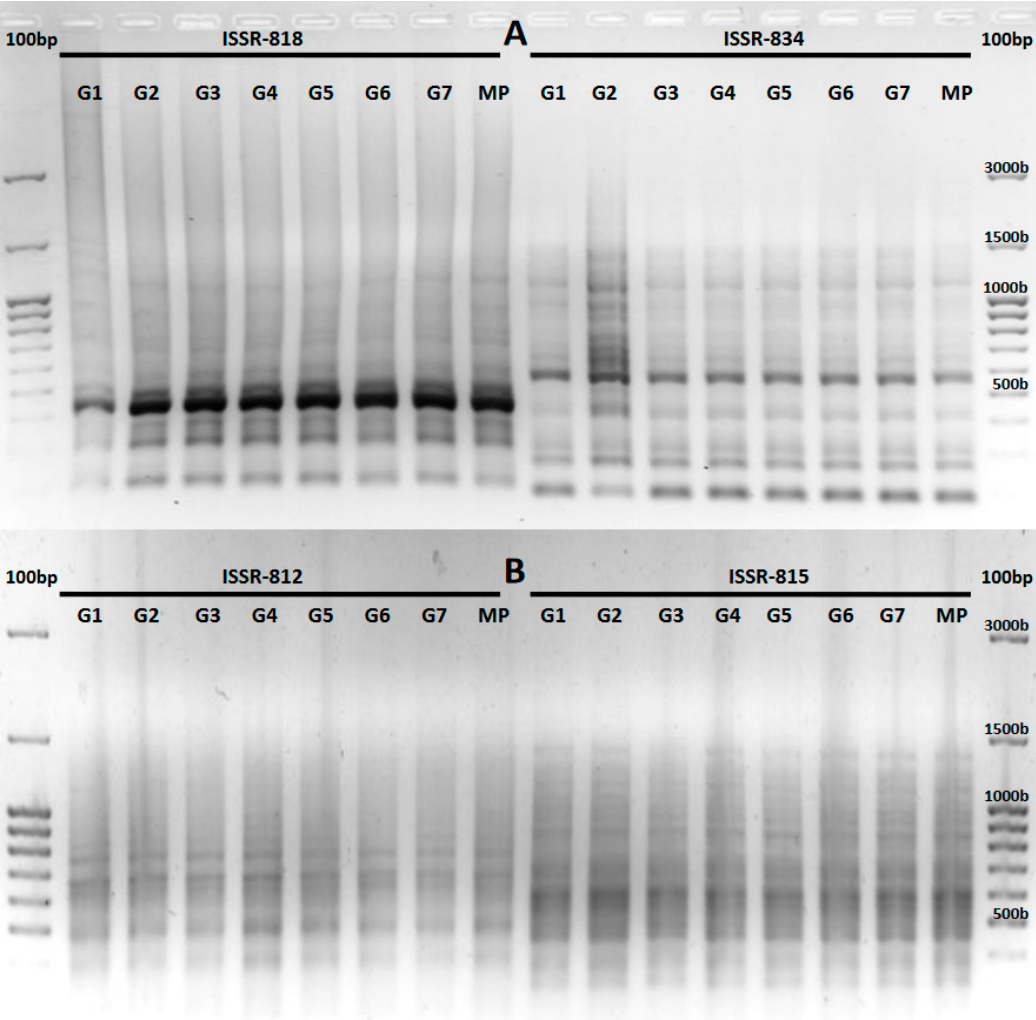
Figure 2. Inter Simple Sequence Repeats (ISSR) amplification pattern, obtained for gDNA of seven micropropagated V. dentatum plantlets (G1–G7) and one V. dentatum mother plant (MP), generated by the primers ISSR-UBC 818, 834 ( A ) and 812, 815 ( B ). The size of the amplified zones was calculated using 100-bp DNA ladder (100–3000 bp) and the image has been converted to black and white and negative.